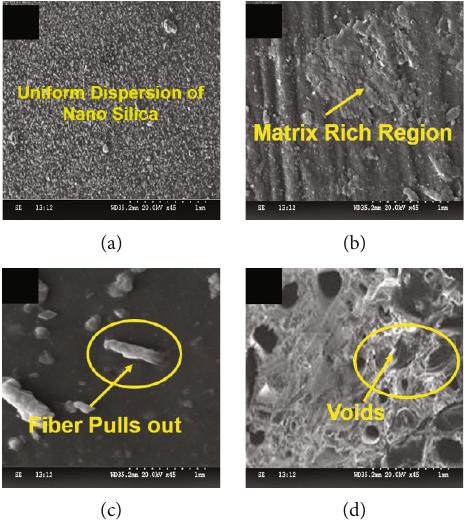
Figure 8: Microstructural analysis of kenaf/carbon/nanosilica-based nanocomposites.